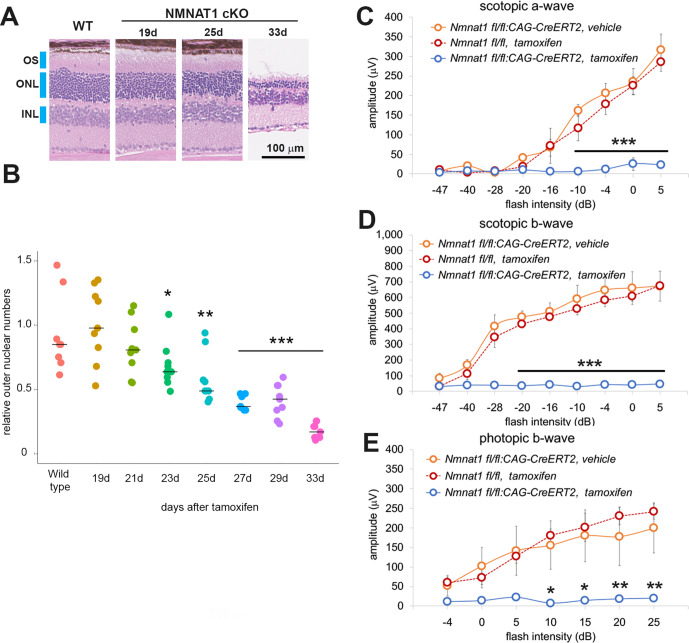
NMNAT1 induces the loss of photoreceptor cells and retinal function.(A) Representative images of hematoxylin and eosin stained sections showing time course of retinal degeneration in NMNAT1 conditional knockout (Nmnat1fl/fl: CAG-CreERT2 + tamoxifen: NMNAT1 cKO) mice at 19 to 33 days post tamoxifen injection or littermate wild-type (WT) mice at 33 days post tamoxifen injection (WT). Blue bars indicate outer nuclear layer (ONL), inner nuclear layer (INL), and outer segment (OS). Similar results were obtained from three mice at each time point. (B) Quantification of relative ONL nuclei numbers of NMNAT1 conditional knockout mouse (Nmnat1fl/fl: CAG-CreERT2 + tamoxifen: NMNAT1 cKO) compared with WT at various time after tamoxifen injection. The graph shows all data points and median (cross bars). Statistical analysis was performed by one-way ANOVA with Holm-Bonferroni multiple comparison (n = 3 mice for each of WT, 19d, 21d, 33d and n = 4 mice for each of 25d, 27d). F(7, 64)=19, p=1.9×10−13. *p<0.05, **p<0.001, and ***p<0.0001 denotes the significant difference compared with WT. (C, D, E) ERG analysis of controls (Nmnat1fl/fl: CAG-CreERT2 vehicle or Nmnat1fl/fl + tamoxifen) and NMNAT1 conditional knockout (Nmnat1fl/fl: CAG-CreERT2 + tamoxifen: NMNAT1 cKO). Graphs show the average and error bars represent the standard error. Scotopic a-wave (C), scotopic b-wave (D), and photopic b-wave (E) are shown. Statistical analysis was performed by two-way ANOVA with Tukey post-hoc test (n = 3 mice for Nmnat1fl/fl: CAG-CreERT2 with vehicle, n = 3 mice for Nmnat1fl/fl at 33 days post tamoxifen injection, n = 4 mice for Nmnat1fl/fl: CAG-CreERT2 at 33 days post tamoxifen injection). F(1, 72)=220, p<2×10−16 between controls (Nmnat1fl/fl: CAG-CreERT2 with vehicle and Nmnat1fl/fl 33 days post tamoxifen injection) and NMNAT1 cKO for scotopic a-wave, F(1, 72)=633, p<2×10−16 between controls and NMNAT1 cKO for scotopic b-wave, F(1, 56)=94, p=1.3×10−13 between controls and NMNAT1 cKO for photopic b-wave. *p<0.05, **p<0.001, and ***p<0.0001 denote a significant difference compared with WT.Figure 2—source data 1.Source data for Figure 2.